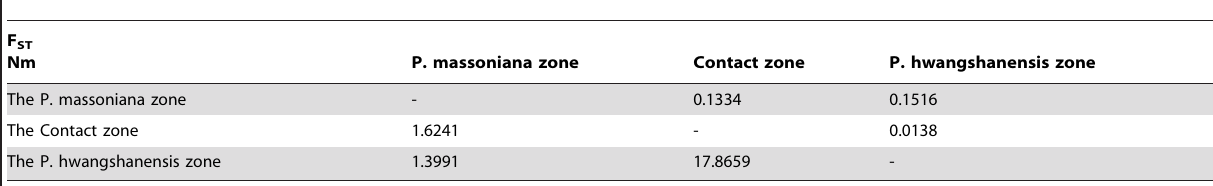
Table 4. Pairwise comparison of F ST and Nm across species zones.